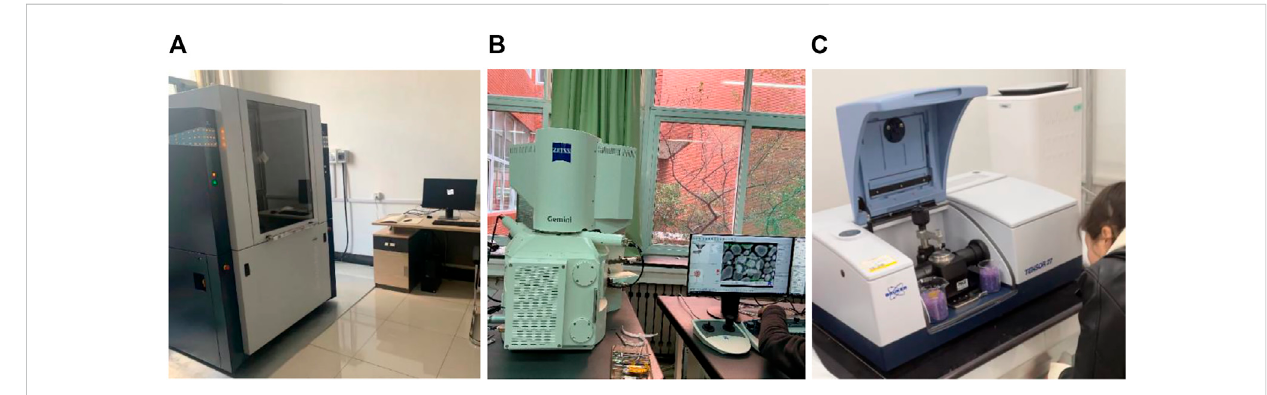
FIGURE 1 Microscopic characterization equipment (A) X-ray diffractometer, (B) SEM, (C)